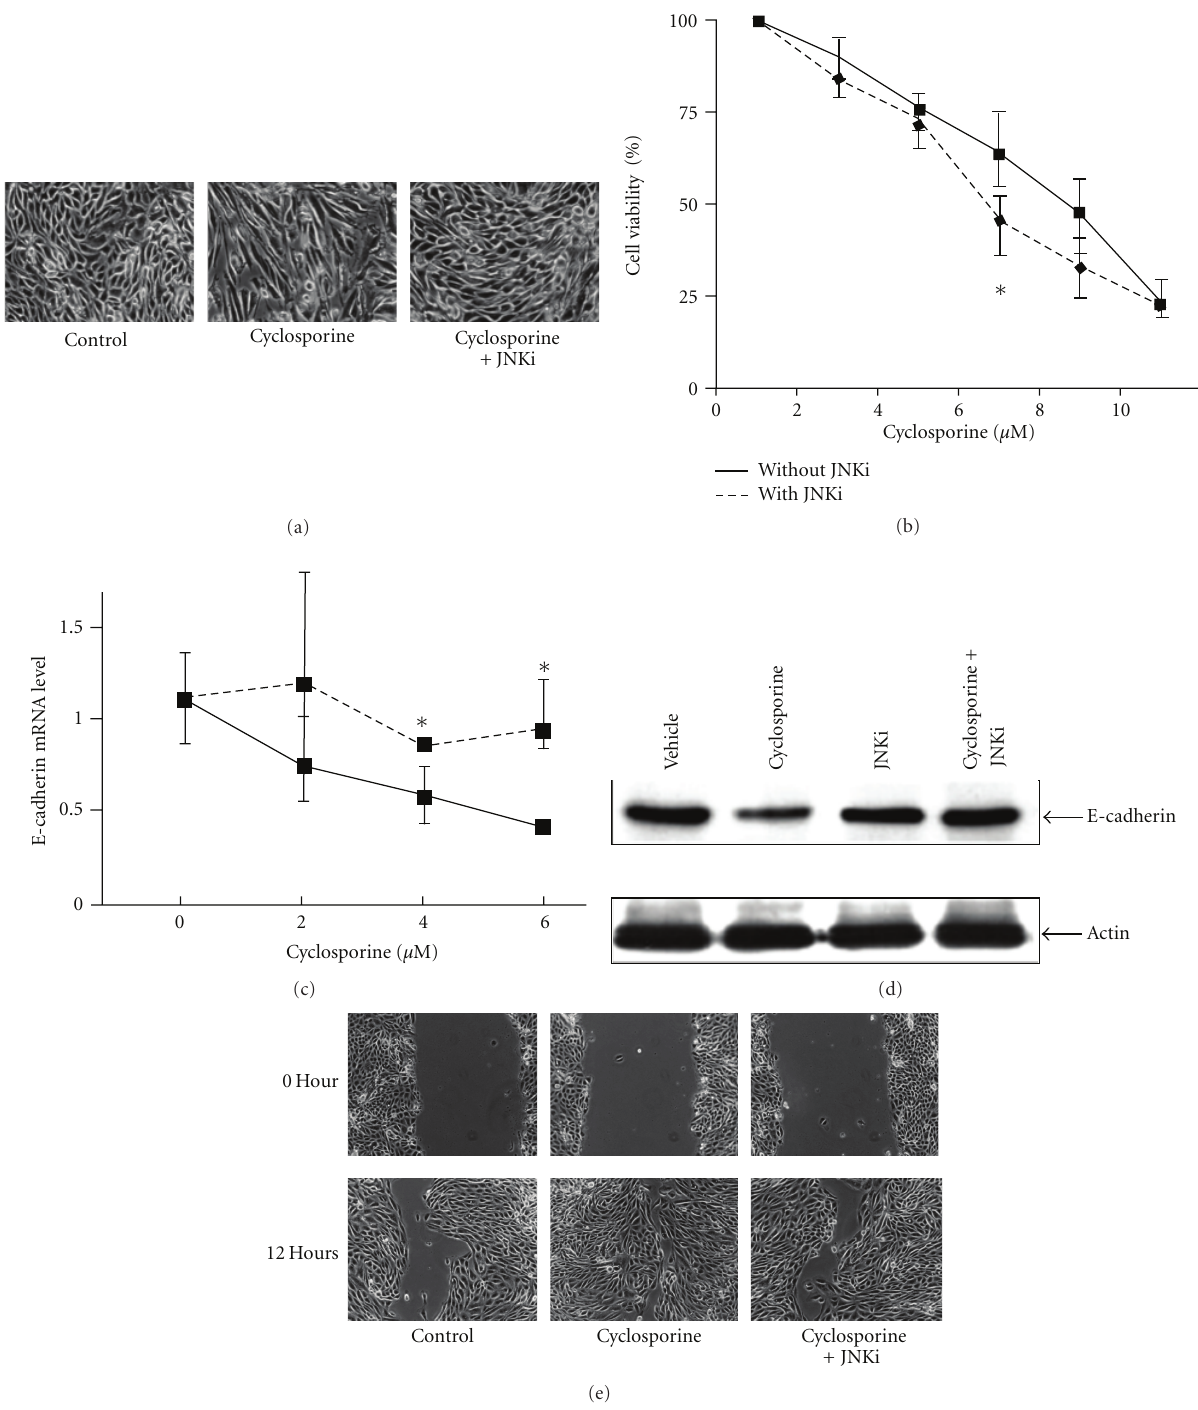
Figure 2: JNK signaling is involved in cyclosporine-induced EPCs. (a) Cellular morphology after 48 h exposure to 6 μ M cyclosporine with or without 2 μ M (L)-JNKI1 was determined using phase contrast microscopy. Bar, 4 μ m. (b). Cell viability was determined using the MTS assay after 72 h exposure to various concentrations of cyclosporine (CsA) with or without 2 μ M (L)-JNKI1; ∗ P = 0 . 04, n = 4. (c) Real-time PCR analysis of E-cadherin mRNA expression after 48h exposure to various concentrations of CsA with or without 2 μ M (L)-JNKI1. (d) Representative western blot of E-cadherin in whole cell lysates after exposure to vehicle, 6 μ M CsA, 2 μ M (L)-JNKI1, and 6 μ M CsA + 2 μ M (L)-JNKI1 for 48 hours. (e) Representative phase contrast micrographs of the initial wounding and 12 hours after wound healing (left). Bar, 50 μ